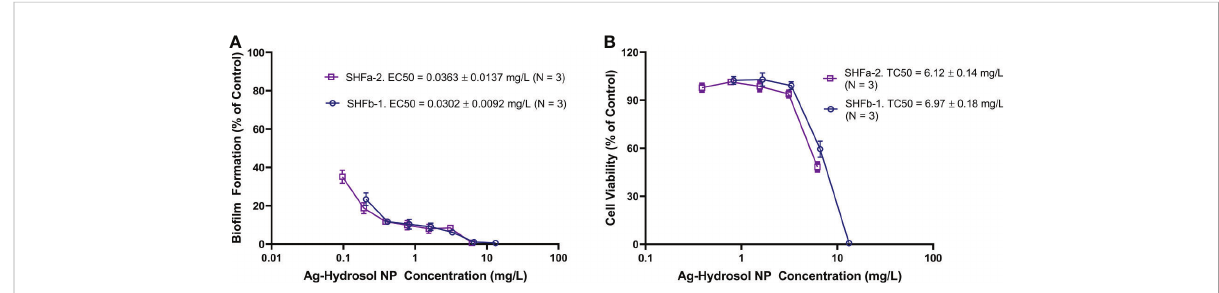
FIGURE 2 Quantitative evaluation of the anti-bio fi lm and cytotoxicity effects of Ag-hydrosol NPs. (A) Composite dose-effect curves for the effect of Ag- hydrosol NPs on E faecium 1449 bio fi lm formation determined using the microtiter plate assay with crystal violet staining. (B) Composite dose- effect curves for the in vitro cytotoxic effect of Ag-hydrosol NPs on human nasal epithelial cells determined by the MTT assay. Error bars represent the standard deviation (SD) of three independent experiments (N = 3).